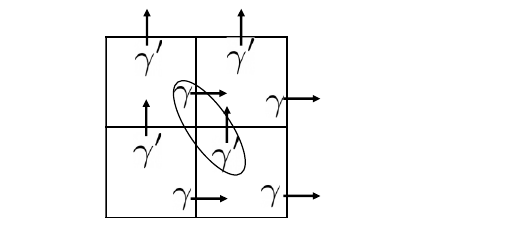
FIG. 14. To match our exact bosonization to the Verstraete- Cirac mapping, we shift our Majorana modes on each face in the following way: (1) shift γ (cid:7) upward and let it be γ on the new f FIG. 16. Kitaev’s honeycomb model. The red, blue, and green face; (2) shift γ f rightward and let it be γ (cid:7) on the new face. edges represent x , y , and z links. For each link, the product of two Pauli matrices on its vertices is mapped to the product of γ and γ (cid:7) on its vertices, shown in Eq.